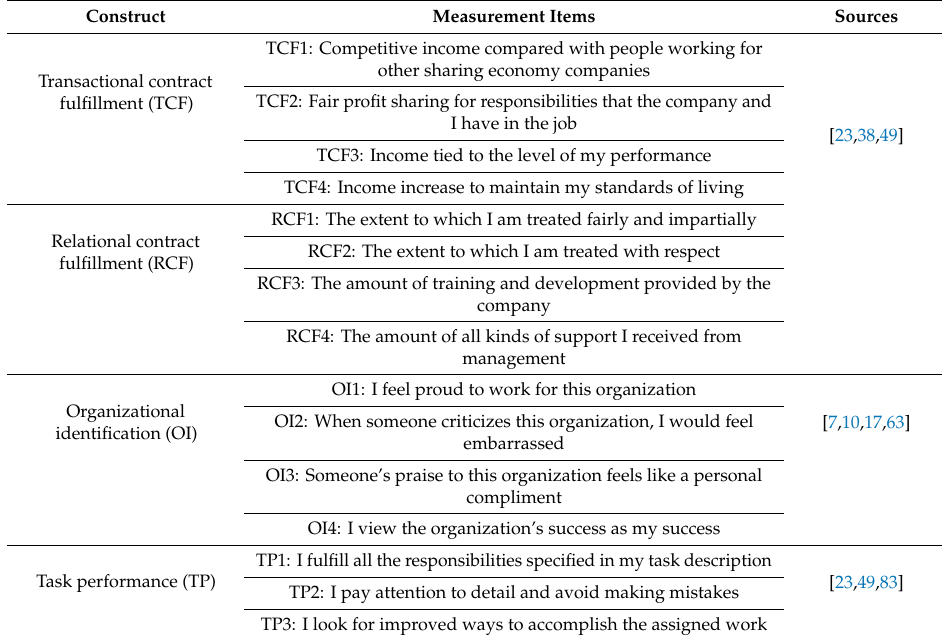
Table 1. Research constructs and measurements.